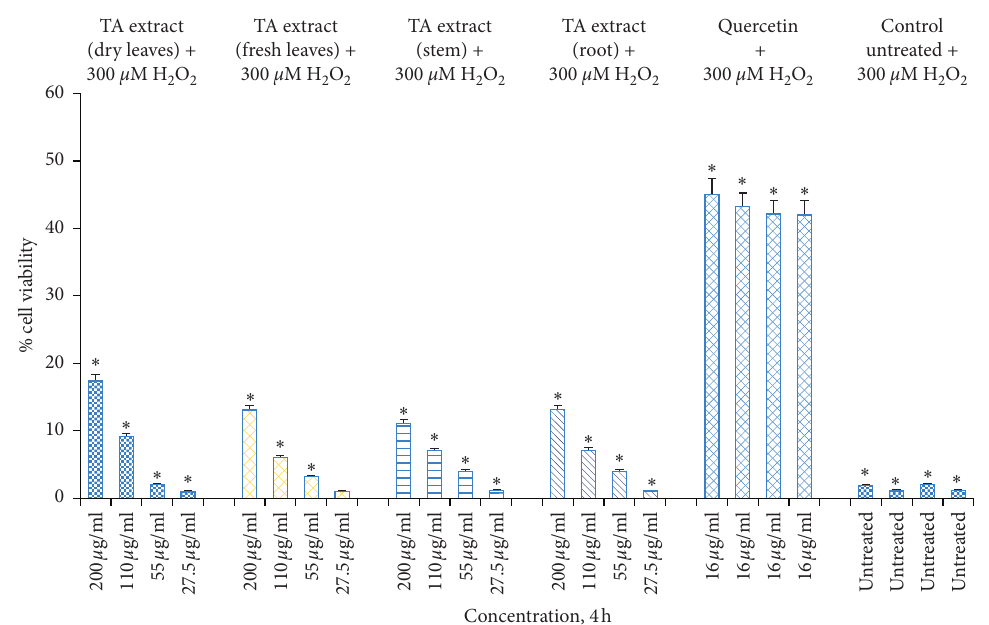
Figure 5: Cell viability determined by MTT assay. Hs27 skin fibroblasts were seeded at a density of 10,000 cells/well in 96-well plates and allowed to incubate overnight to attach to the surface. Next day, treat the cells with TA extracts (fresh and dry leaf, stem, and root extracts) for 4h along with quercetin as a positive control (16 μ g/mL) and control as untreated. After the completion of treatment, expose the pretreated cells with 300 μ M of H ₂ O ₂ for 1h. Data shown as mean ± SEM; n � 3, ∗ p < 0 .